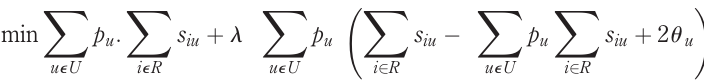
objective function represents the cost of transportation, the second and third parts represent the cost of non-compliance with the soft time window, the fourth part represents the fi xed cost of constructing a distributor, the fi fth part represents the fi xed cost of the vehicle, and the sixth part represents the objective function of the cost of